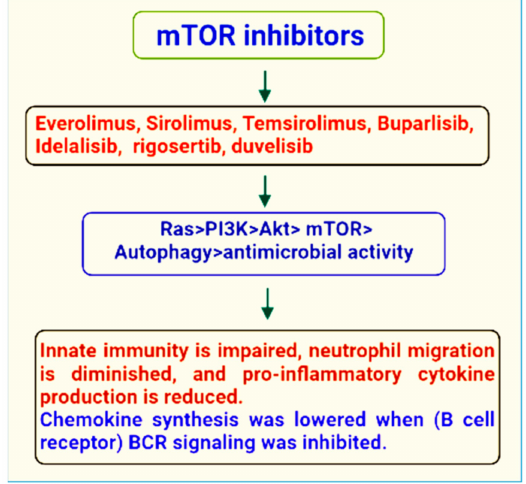
Figure 2. mTOR inhibitors of therapeutic